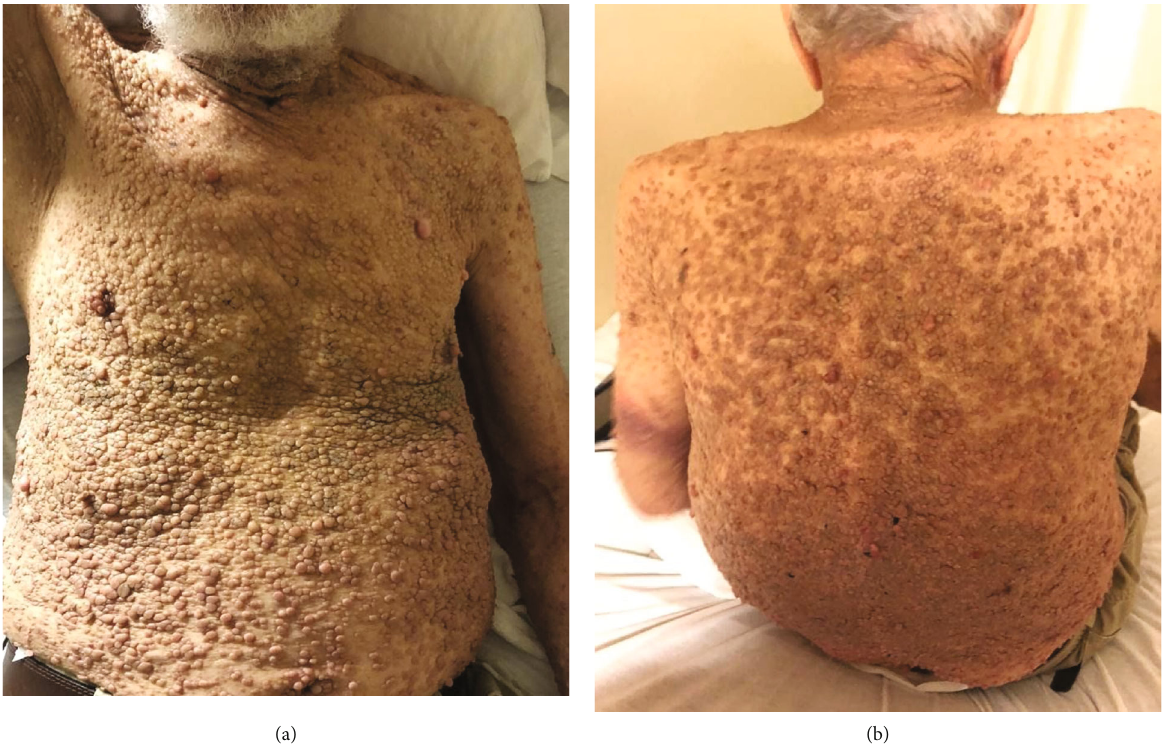
Figure 1: (a, b) The classic neuro fi bromas of neuro fi bromatosis type 1 covering the entire surface of the upper extremities and trunk.